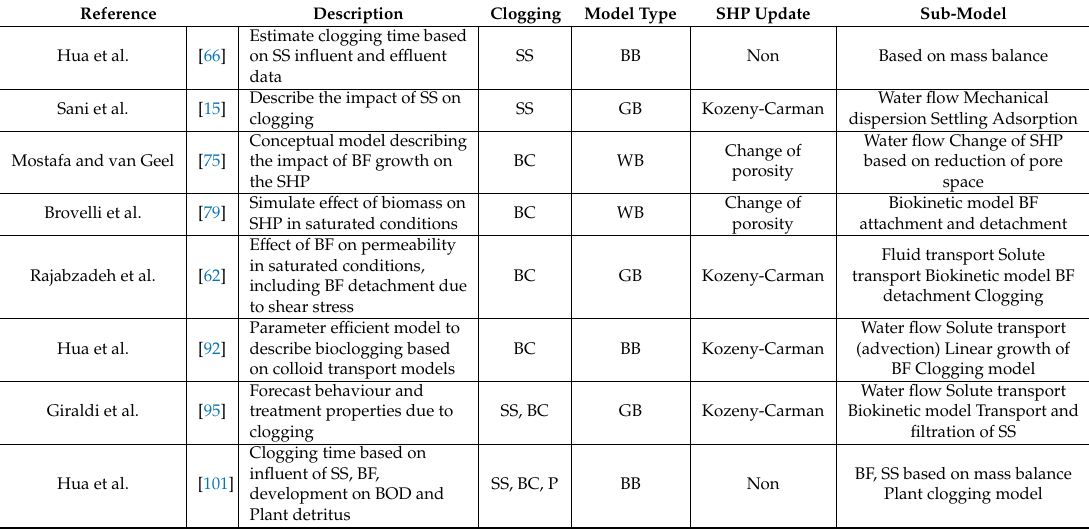
Table 6. Overview on the modelling studies